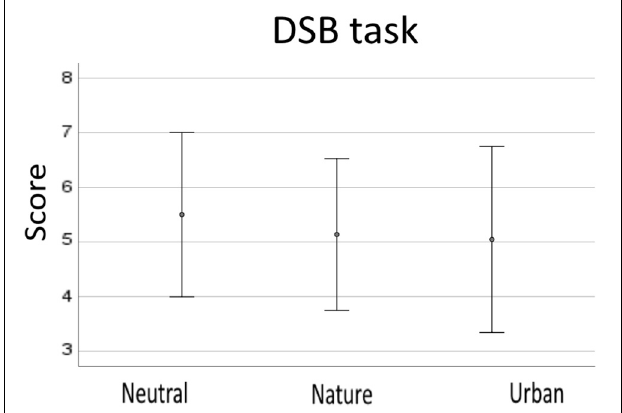
FIGURE 3 | Descriptive data from the DSB task for neutral, nature, and urban experimental condition. Error bars show standard deviations (SD).